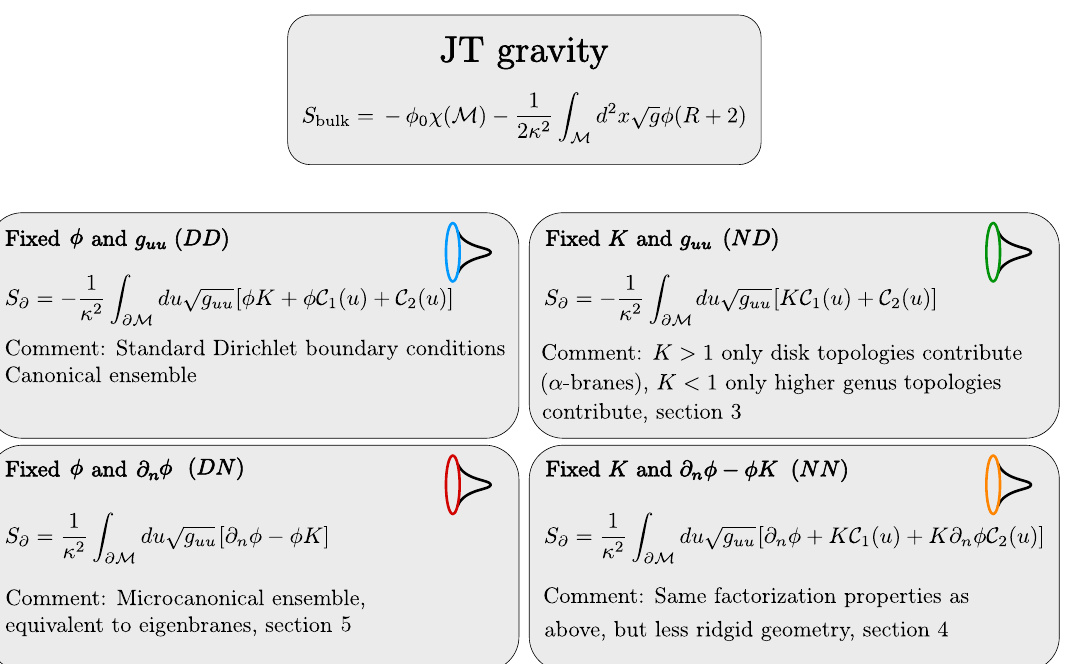
Figure 1 . Summary of the boundary conditions considered in this paper. On the left column, one can see the boundary conditions for fixed dilaton φ (D) on the boundary, whereas the right column is for fixed K , i.e., Neumann boundary conditions on the dilaton (N). This is indicated by the first letter of the two letters in brackets. The rows are analogous, but then for the boundary metric g and is specified in the second letter in